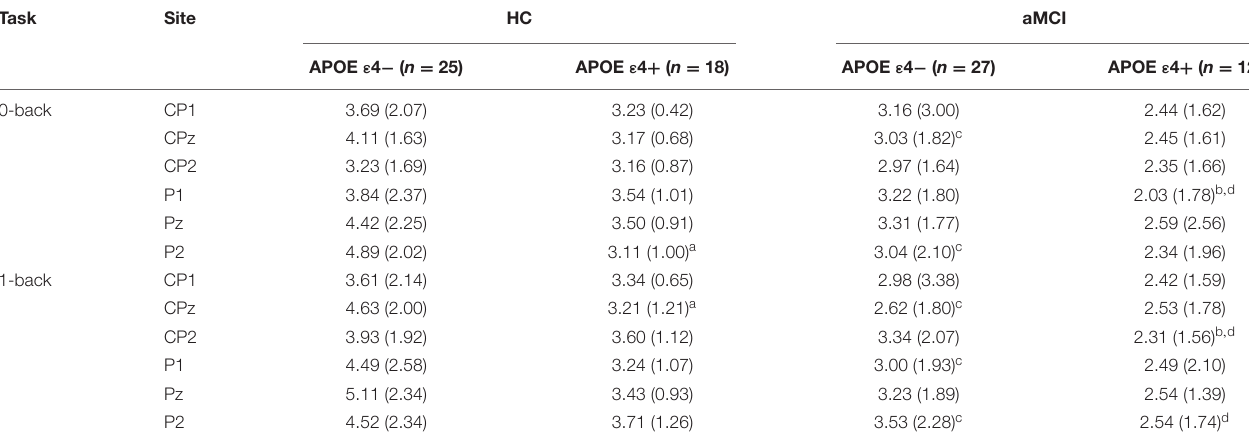
TABLE 3 | Event-related potential (ERP) data (P300 amplitude) for HC and aMCI patients with different APOE ε 4 status. Task